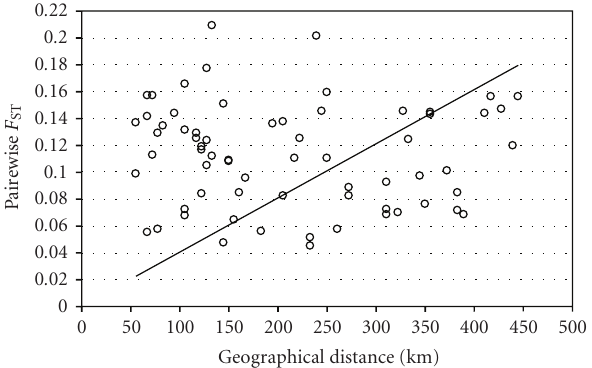
Figure 1: Scatterplots of pairwise F ST versus geographical distance. Mantel test shows significant association ( r = 0 . 432; P = . 007) .